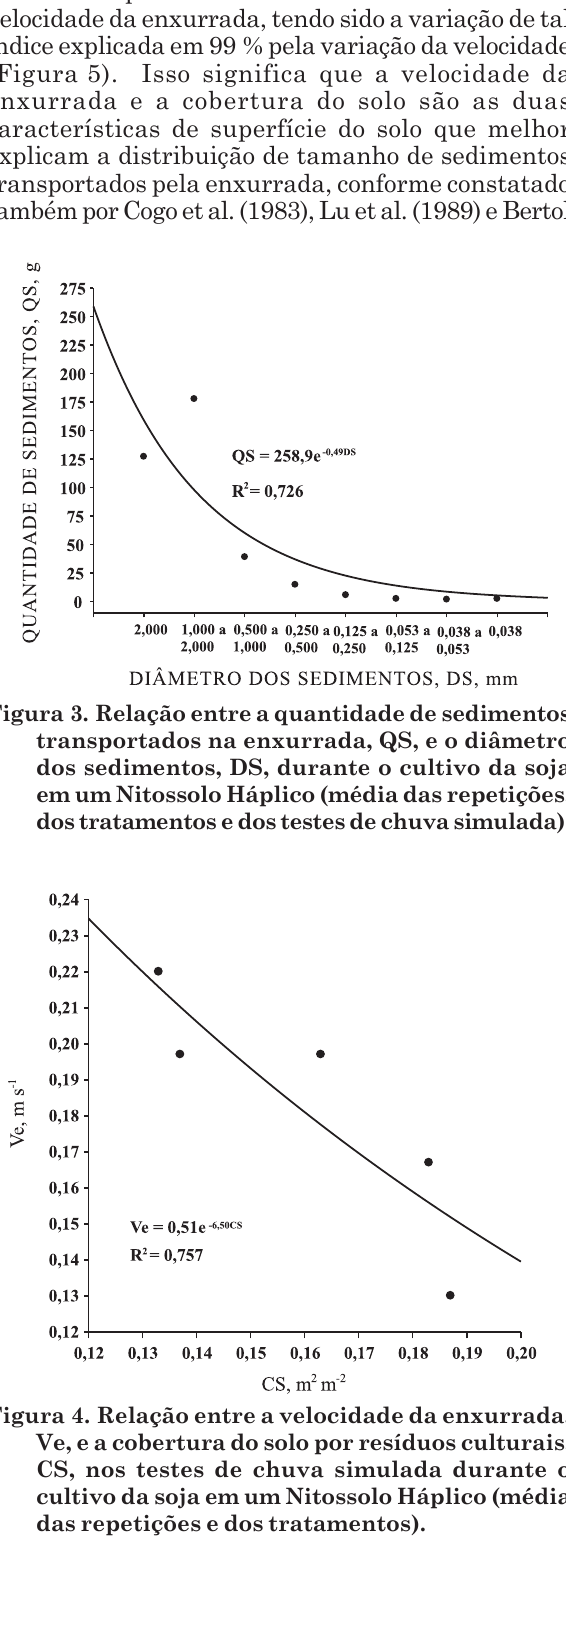
dos sedimentos 50